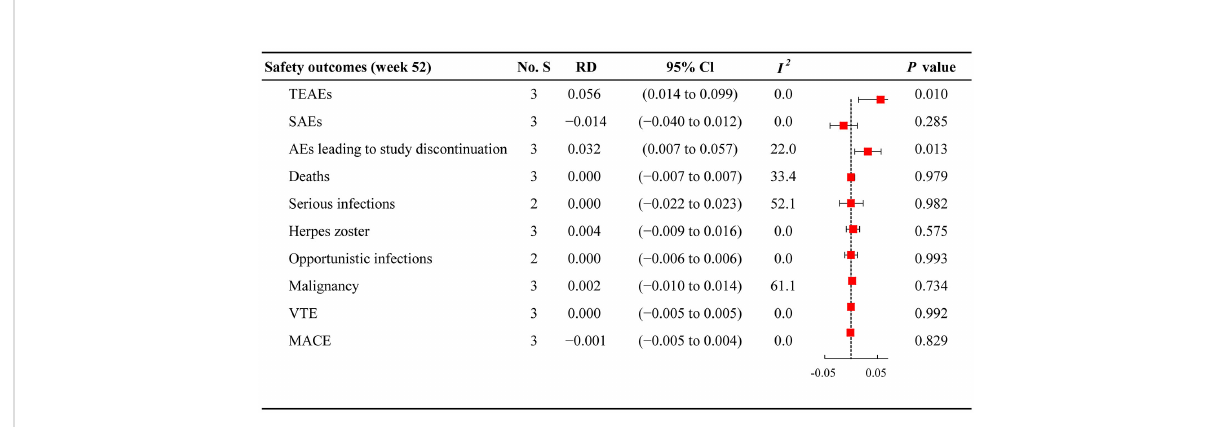
FIGURE 3 Forest plots of safety outcomes for JAKi combination therapy versus JAKi monotherapy No. S, numbers of studies; RD, risk difference; CI, con fi dence interval; I 2 , heterogeneity; TEAEs, treatment-emergent adverse events; SAEs, serious adverse events; AEs, adverse events; VTE, venous thromboembolism; MACE, major adverse cardiovascular